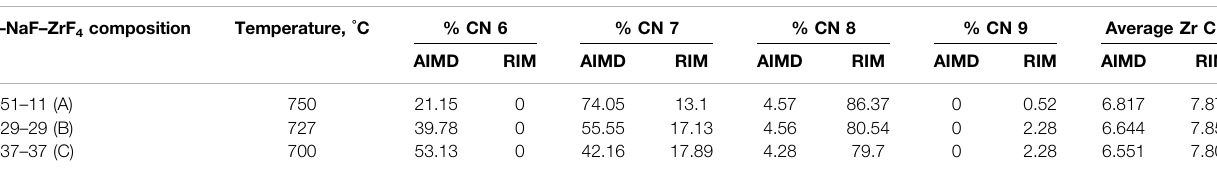
TABLE 1 | Zr Coordination number as calculated by AIMD and RIM-IPMD.